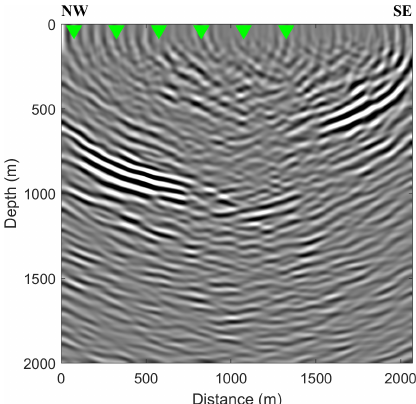
Figure 6. Final RTM section of the Blötberget dataset. The green triangles are where common image gathers (CIGs) are shown later in the